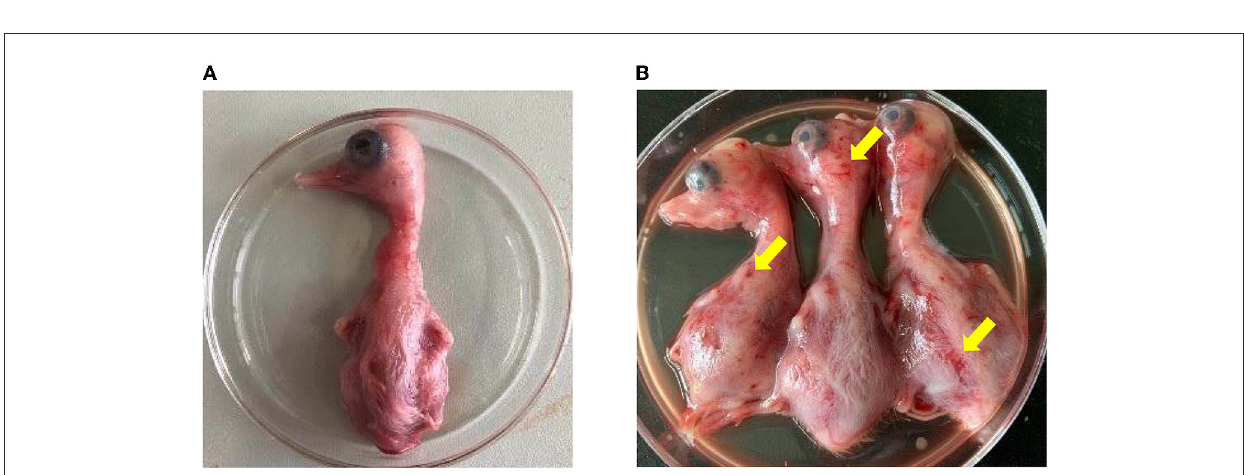
FIGURE3 The pathogenicity of NDRV to duck embryos. (A) The duck embryos inoculated with PBS as the control. (B) The duck embryos inoculated with NDRV isolates in this study showed hemorrhage and oedema. The two duck embryos on the left and the third one in (B) were inoculated with NDRV isolated from Xinxiang city (case 1) and Jiaozuo city (case 2),